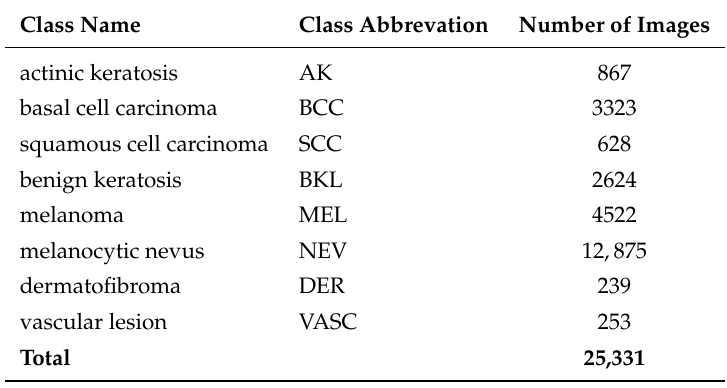
Table 1. International Skin Imaging Collaboration (ISIC) archive-2019, number of images per skin lesion